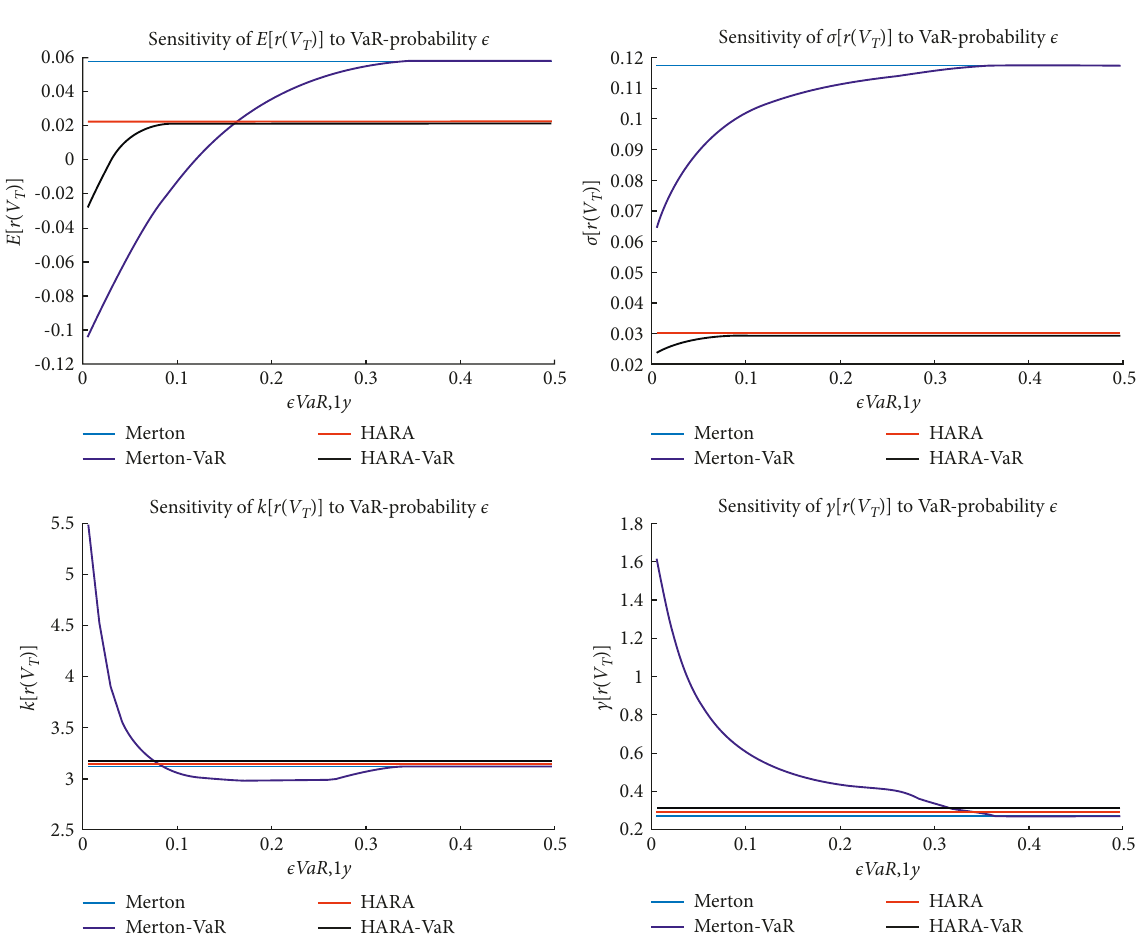
for Merton (Power), Merton-VaR (Power-VaR), HARA, and VaR